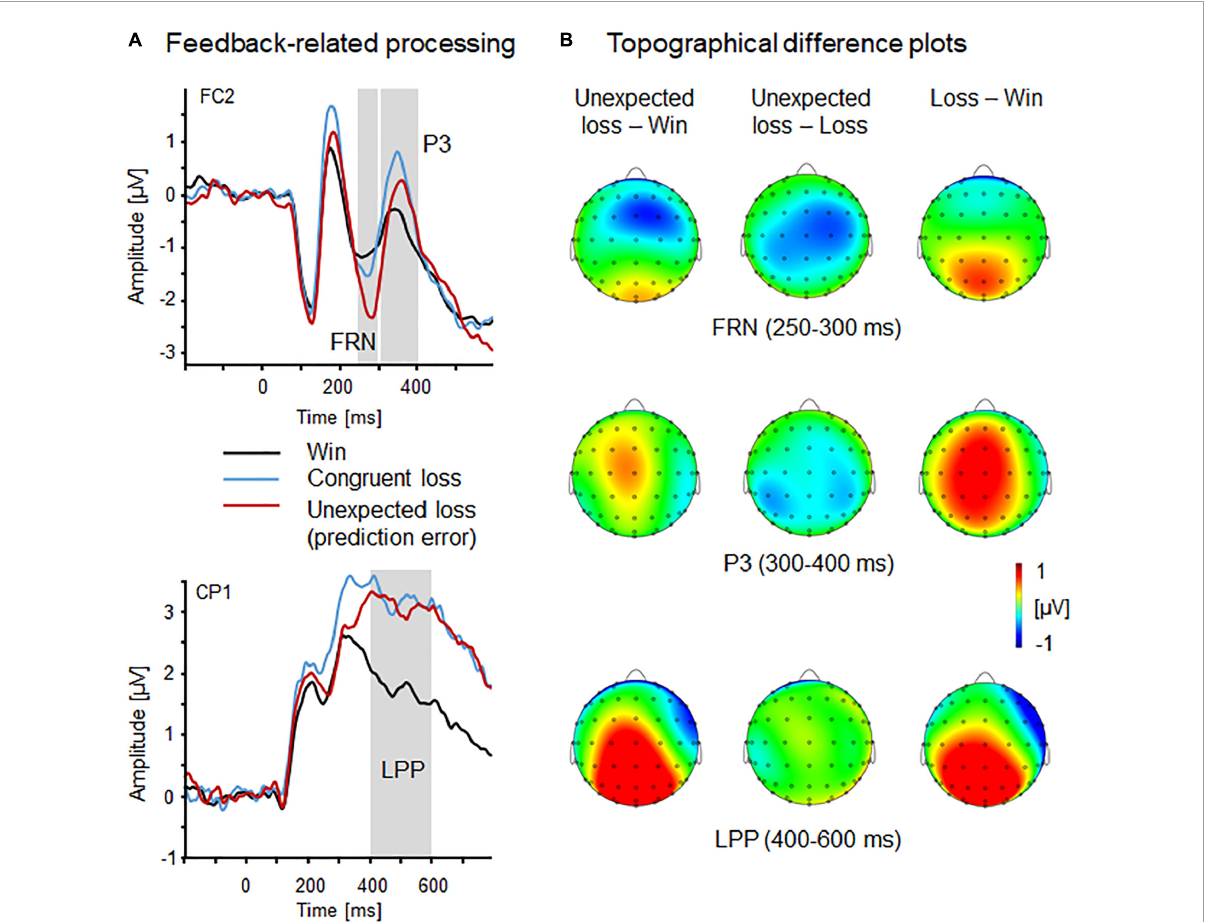
FIGURE4 Feedback-related processing indicated by FRN, P3, and LPP components. (A) Event-related brain potential waveforms as a function of feedback type (win, congruent loss, and incongruent loss) revealed by fronto-central FRN and P3 (FC2) and centro-parietal LPP (CP1). (B) Topographical difference plots (incongruent loss—win, incongruent loss—loss, and loss—win) displaying feedback type effects for the FRN, P3, and LPP components. Waveform differences are displayed on the top view of a model head.